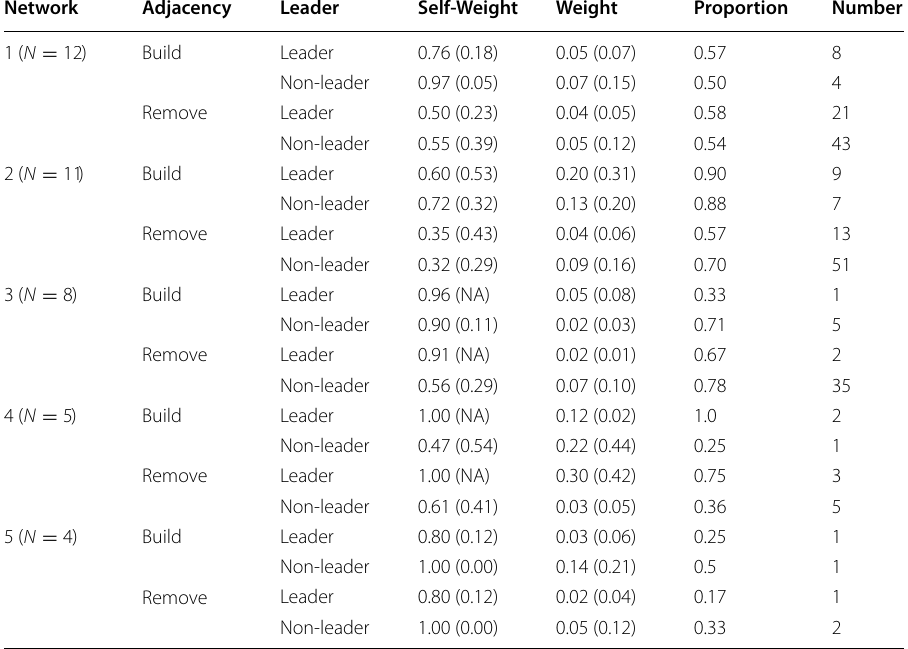
Table 20 Mean self-weight, mean weight, proportion, and number by network, adjacency matrix and leadership for